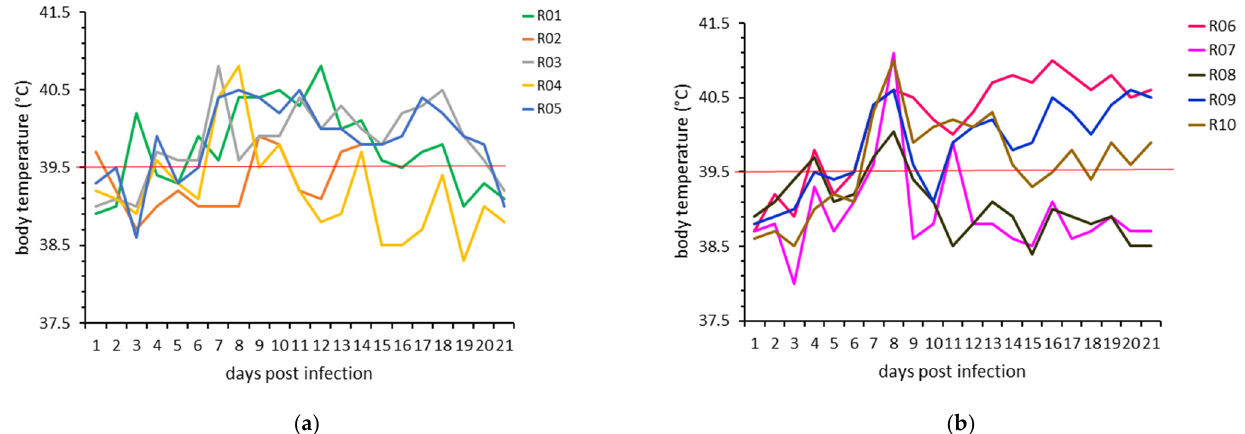
Figure 2. Daily body temperature of each animal in ( a ) experiment 1 and ( b ) experiment 2. Solid line: fever cut-off (39.5 °C) for prolonged fever.